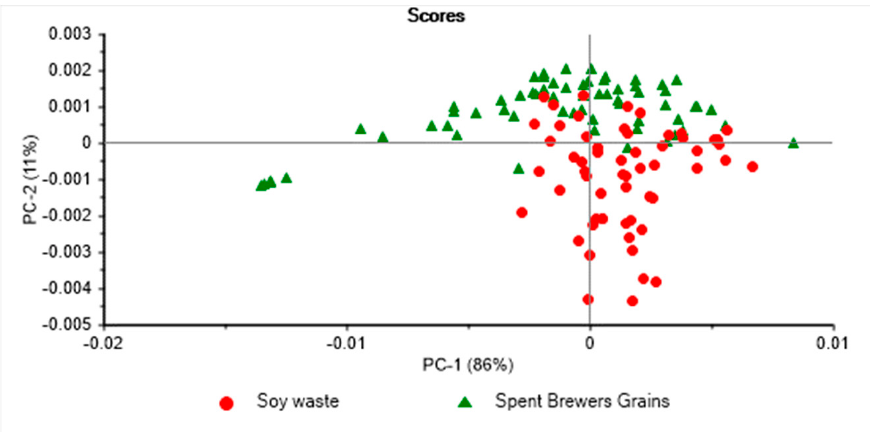
Figure 3. Principal component score plot of 5th instar larvae reared on soy waste and spent brewer’s grains and analysed using near infrared spectroscopy.